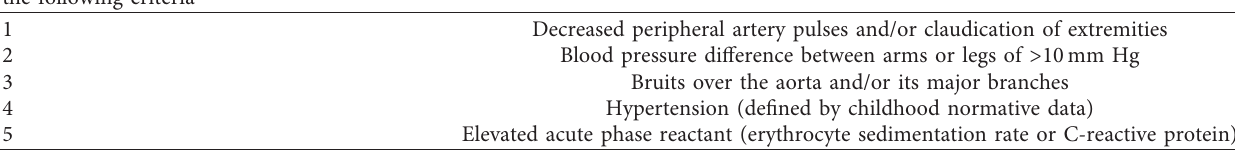
Table 1: Proposed classification criteria for childhood Takayasu arteritis. Angiographic abnormalities (conventional, CT, or magnetic resonance angiography) of the aorta or its main branches and at least one